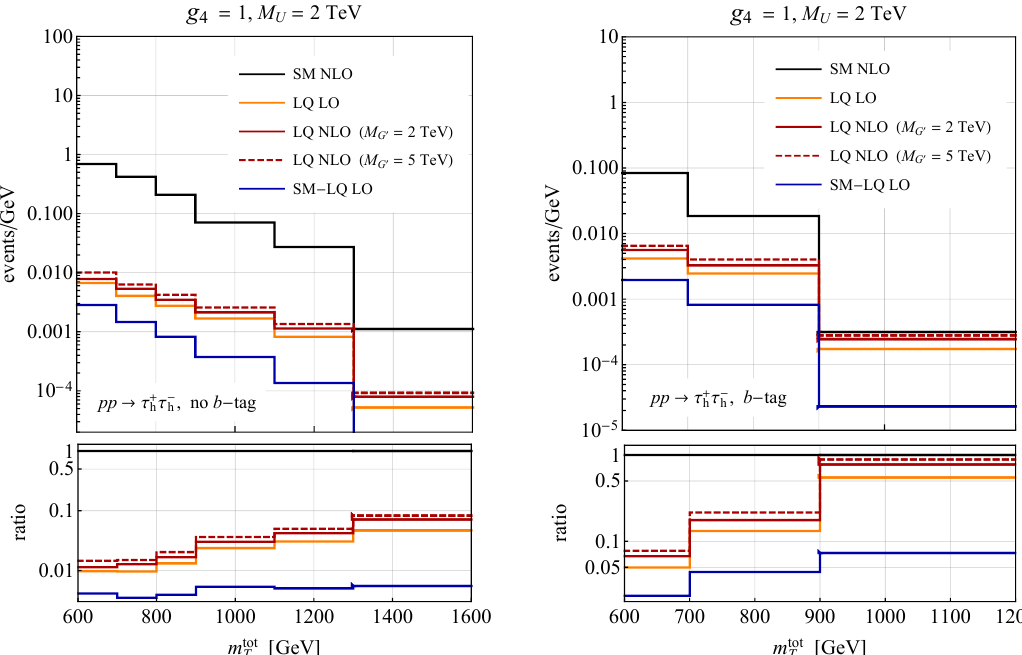
Figure 6 . Distributions of m tot in the no b -tag (left panel) and the b -tag (right panel) category T in the final state containing two hadronic tau leptons. The black curves correspond to the SM expectations of the DY background provided by CMS in [54]. This search is based on 138 fb − 1 of √ integrated luminosity collected in pp collisions at s = 13 TeV . The yellow and red curves instead represent the LQ LO and LQ NLO predictions assuming g 4 = 1 and M U = 2 TeV . In the case of the solid (dashed) red lines the coloron mass is set to M G 0 = 2 TeV ( M G 0 = 5 TeV ). The blue histograms illustrate the size of the interference effects between the LQ signal and the SM background called SM-LQ LO. The definition of the signal regions (SRs) and other experimental details can be found in the main